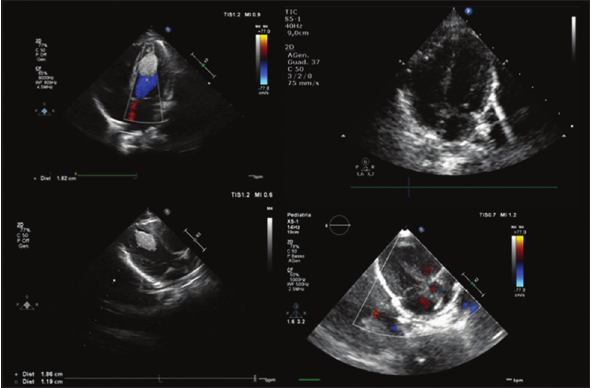
Figure 1: Pre-operative and post-operative echocardiogram compared